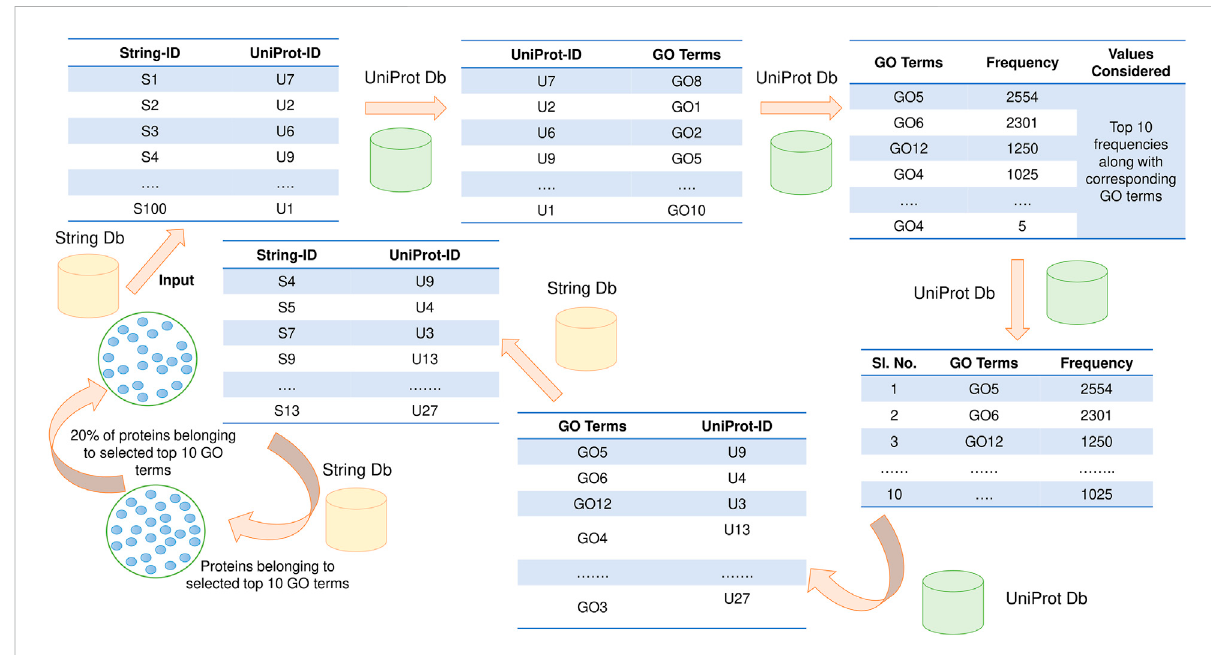
FIGURE 1 Functionally active target protein selection. Two databases: STRING and UniProt, have been used for this